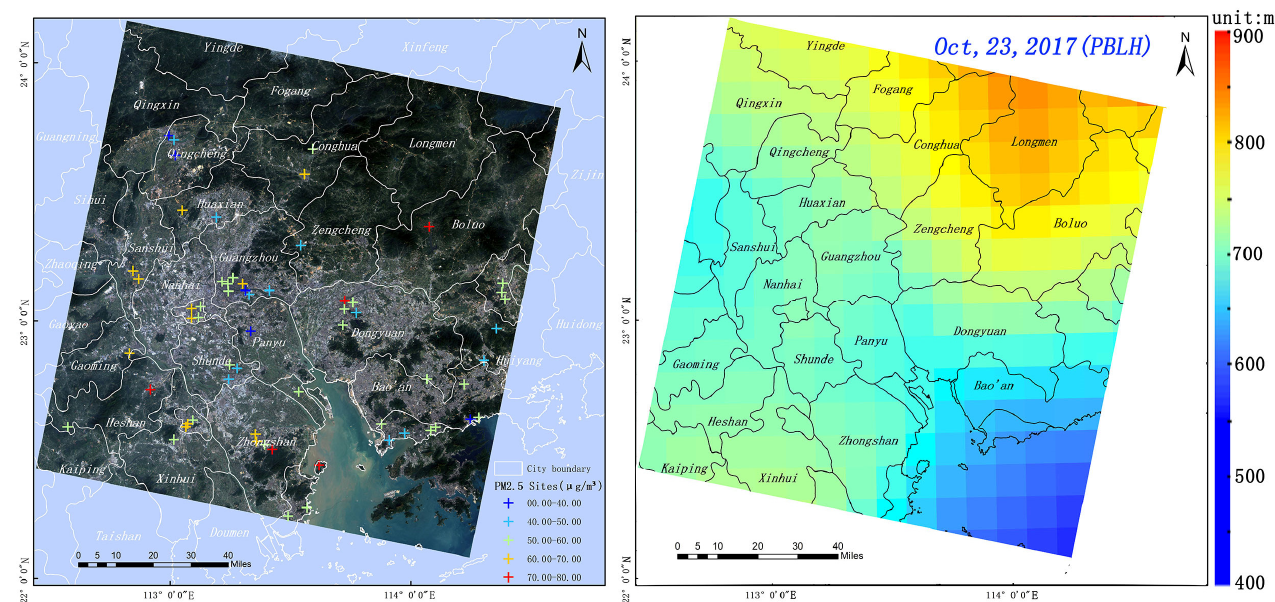
Figure 1. ( Left ): The study area (part of the PRD) and the distribution of PM 2.5 sites (in gradient colors corresponding to the annual average PM 2.5 mass concentration on 23 October 2017); ( Right ): PBLH data in the study area (using the data on 23 October 2017 as a display).